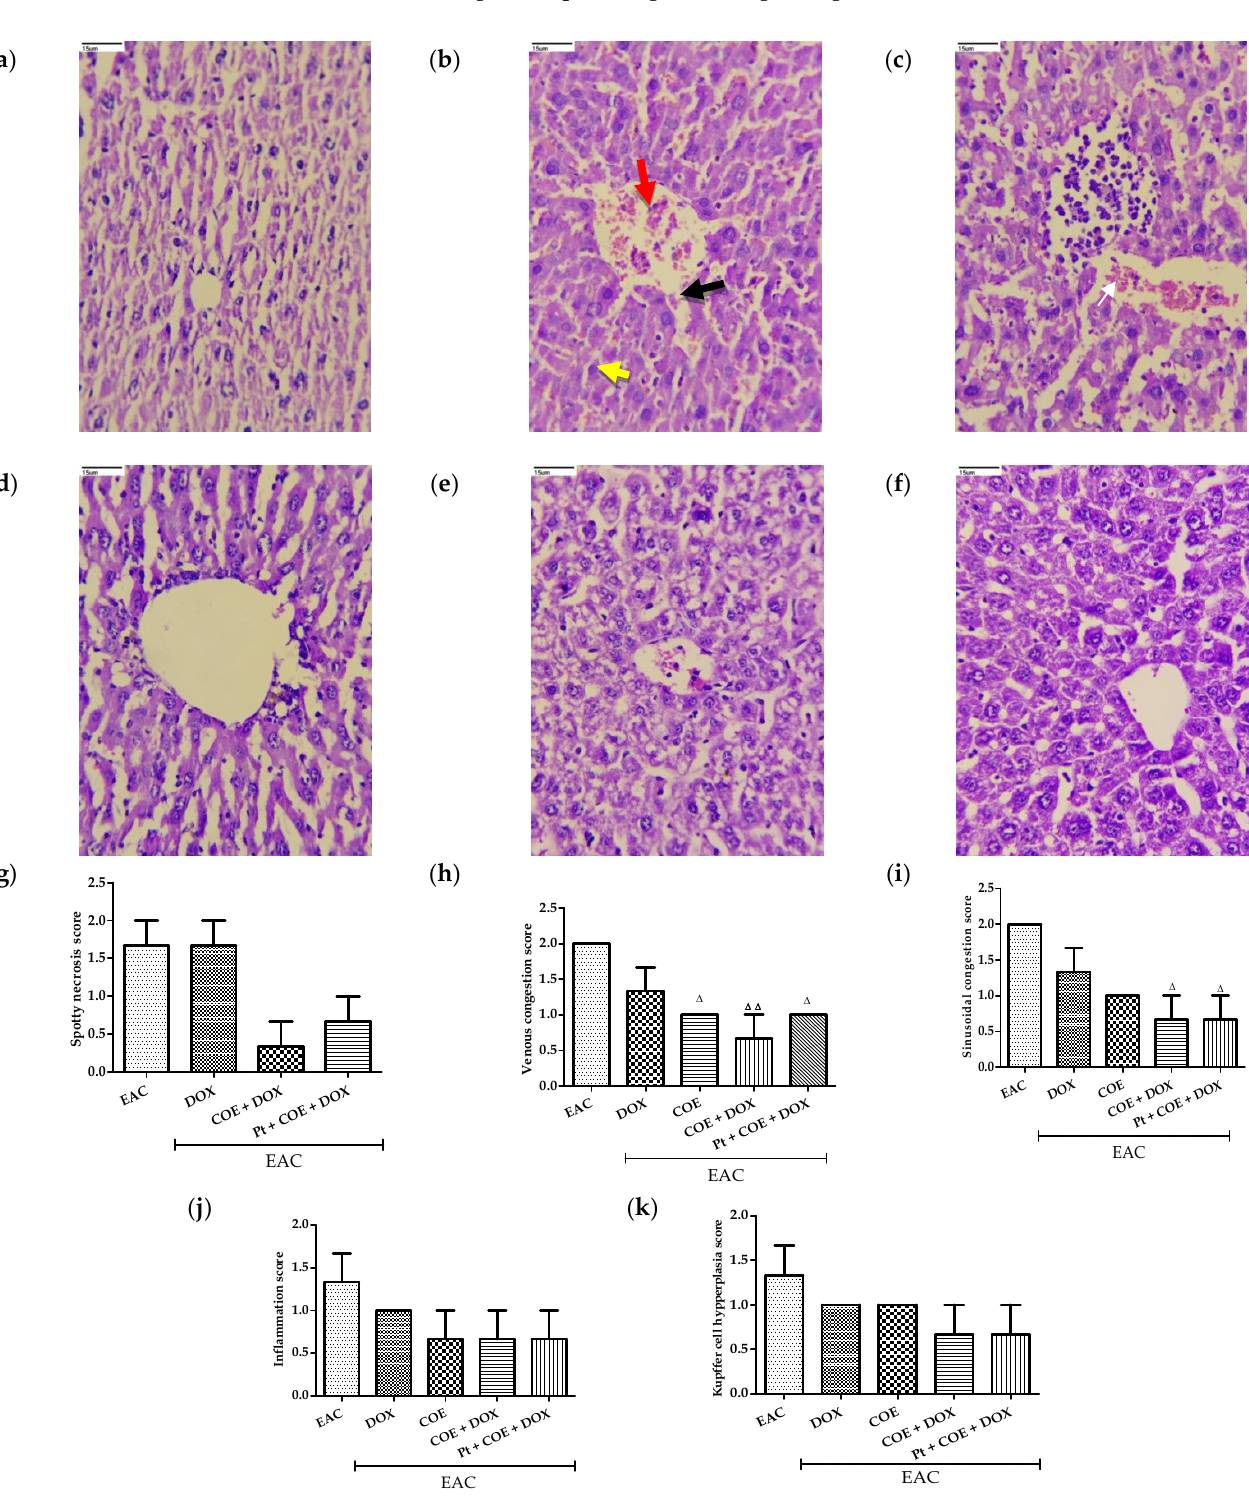
Figure 5. Effect of COE on liver histology. Photograph of liver sections of different treatment groups stained with haematoxylin and eosin. Plates at 40 × magnification. ( a ) Normal, ( b ) EAC, ( c ) DOX, ( d ) COE, ( e ) COE + DOX, ( f ) Pt + COE + DOX, ( g ) Spotty necrosis score, ( h ) Venous congestion score, ( i ) Sinusoidal congestion score, ( j ) Inflammation score, ( k ) Kupffer cell hyperplasia score. EAC group ( b ) showing central vein congestion (red arrow), venous congestion (black arrow), inflamma- tion (yellow arrow) and DOX group ( c ) showing sinusoidal congestion (white arrow). All values are expressed as the mean ± SEM (n = 3). Data were analysed using one-way analysis of variance (ANOVA) followed by Tukey’s test. Δ p < 0.05, ΔΔ p < 0.01, compared with EAC.